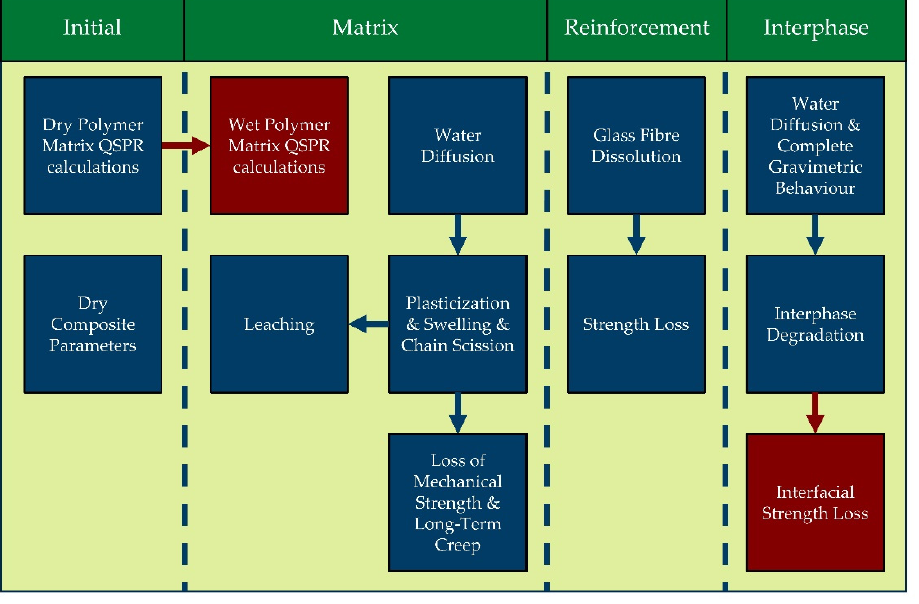
Figure 7. Modelling toolbox modules for predicting environmental ageing of composites. Red coloured modules indicate that such models are not yet available, whereas blue ones are complete (and described in the previous chapter).